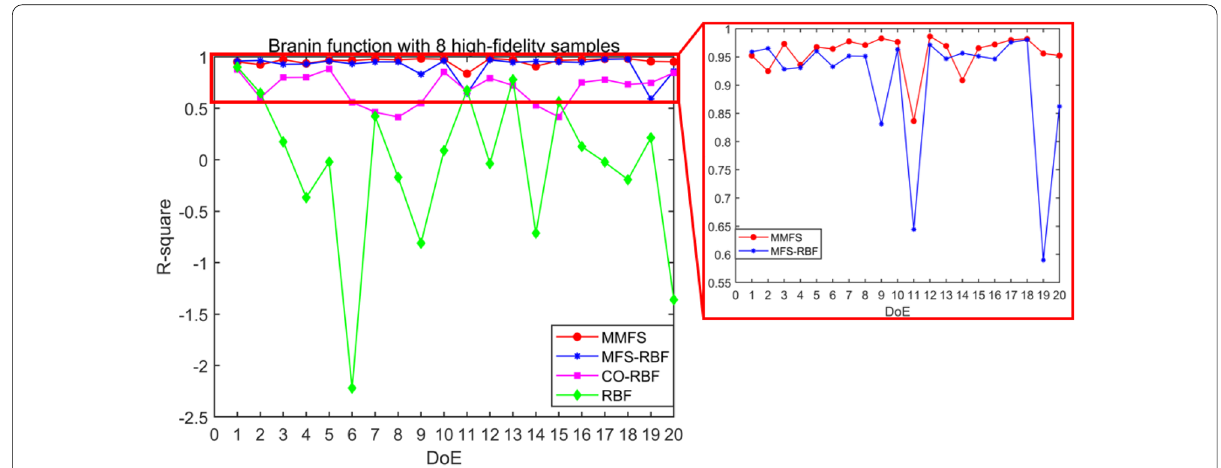
Figure 3 Model accuracy of Branin